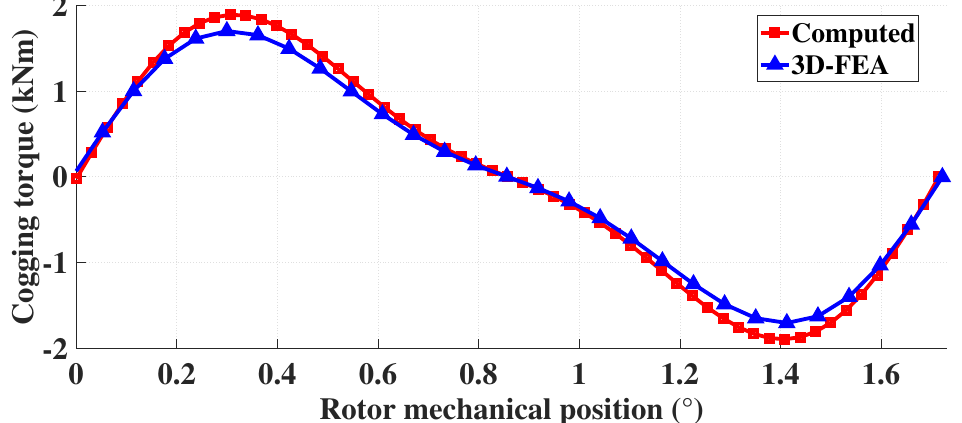
Figure 19. Computed and 3D-FEA cogging torque profile as a function of rotor mechanical position. The calculated cogging torque is also in good agreement with the 3D-FEM